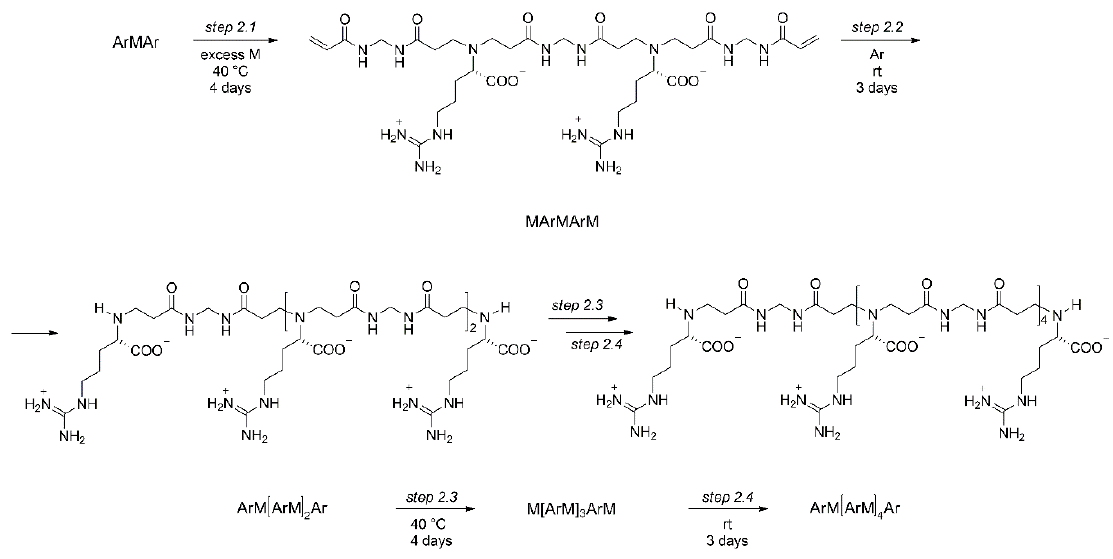
Scheme 2. Synthesis of L ‐ arginine ‐ based building